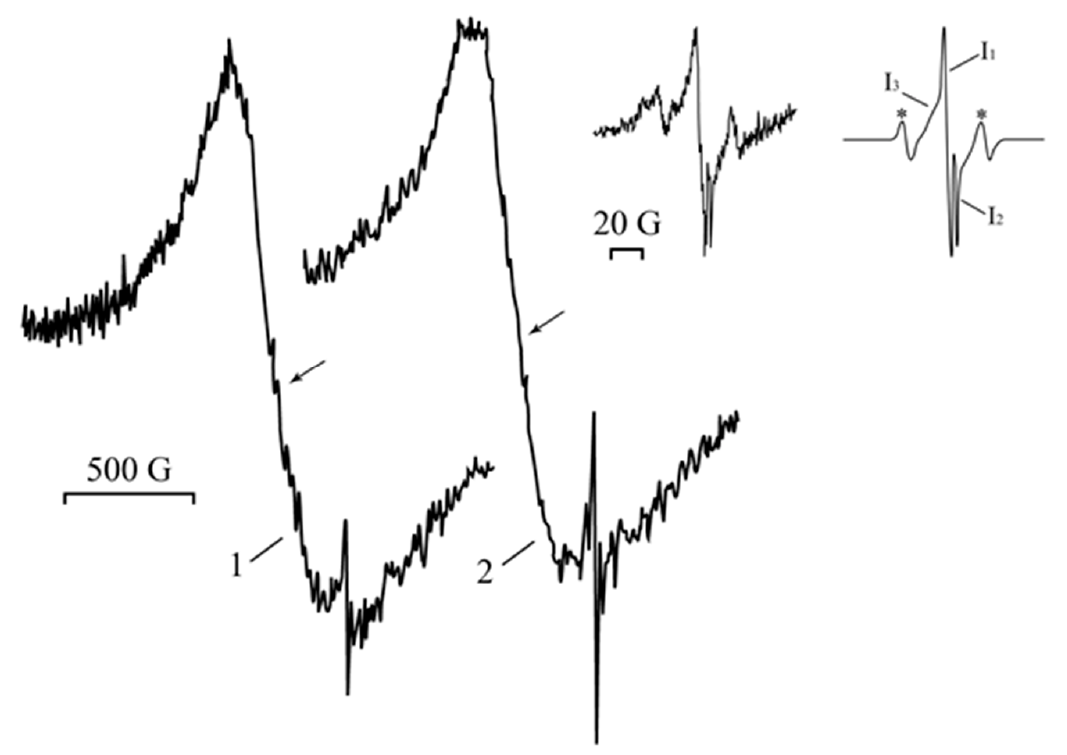
Figure 6. EPR spectra of PAAg film during UV-irradiation: 1—after 3 min, 2—after 1 h; inset: experimental narrow signal ( left ) and simulated ( right ), detailed explanations are below in the text; the arrow indicates a g -factor equal to 2.20.